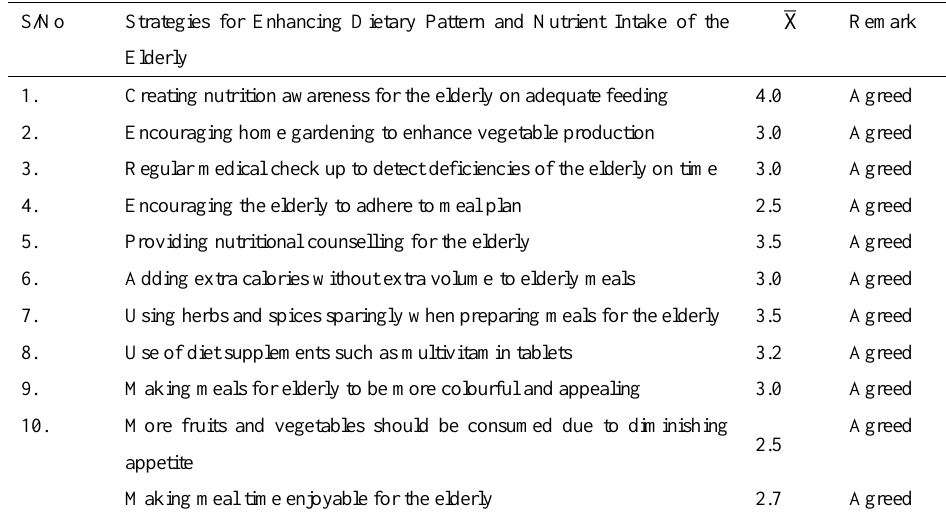
Table 2: Mean Responses on the Strategies for enhancing dietary pattern and nutrient intake of the elderly (60 years and above) in Idemili North Local Government Area, Anambra